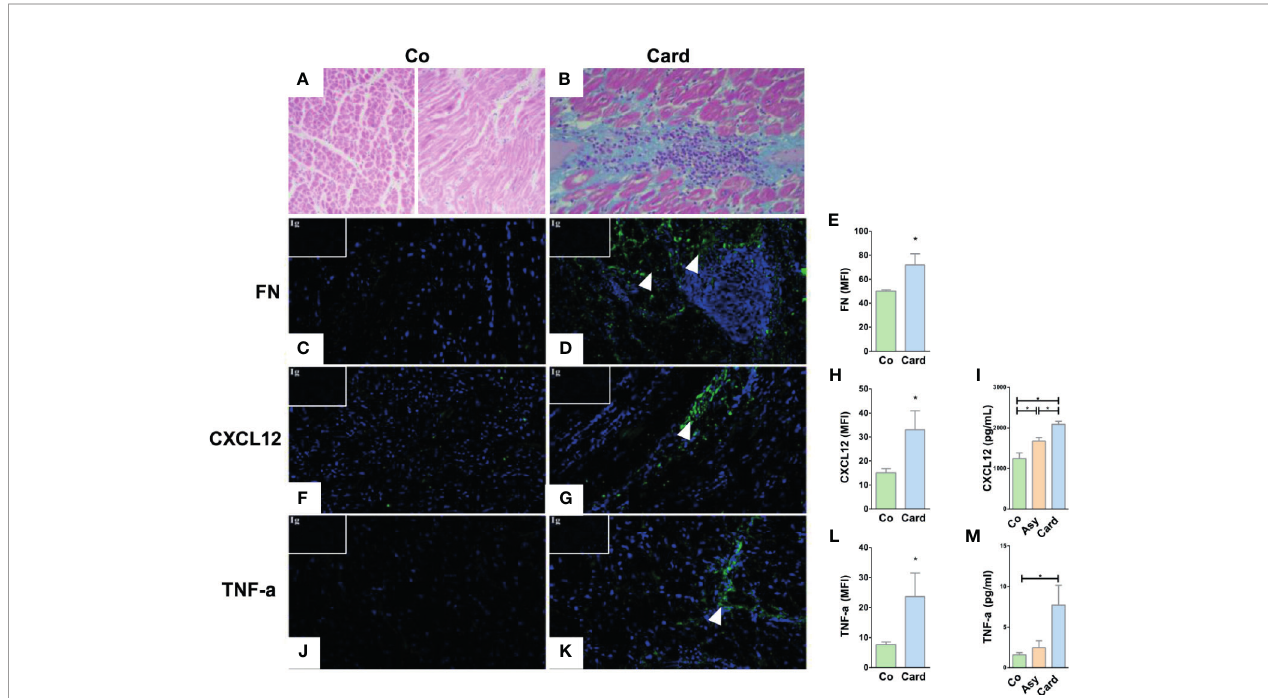
FIGURE 1 | Histological and immuno fl uorescence analyses of the cardiac tissue of Control subjects and T. cruzi – infected patients with chronic myocarditis. Hematoxylin and eosin staining of healthy myocardium from Control individuals (A) and from Cardiac patients (B) showing the typical diffuse in fl ammatory in fi ltrate of T. cruzi chronic infection associated with the in fl ammatory cell in fl ux. Immuno fl uorescence images reveals an increased fi bronectin (FN) deposition ( fi bronectin in green, cell nuclei in blue) in the heart sections from Cardiac patients compared to Controls (C, D) . The mean fl uorescence intensity (MFI) of fi bronectin was also increased in the Cardiac group (E) . CXCL12 immunolabeling (CXCL12 in green, cell nuclei in blue) showed an augmented expression (F, G) and MFI (H) in Cardiac patients compared to Controls. Systemic amounts of CXCL12 are also enhanced in T. cruzi – infected individuals, despite being Asymptomatic or Cardiac (I) . Immuno fl uorescence images of heart sections from Cardiac patients showing an increased TNF- a expression (TNF- a in green, cell nuclei in blue) (J, K) and MFI (L) compared to Controls. Systemic amounts of TNF- a are also enhanced in Cardiac individuals (M) . Isotype controls are shown in the upper left corner of each image. In all cases, MFI was evaluated by measuring fi ve images/heart per study group (Control, n = 3 and Cardiac, n = 3). *p < 0,05 versus Controls. Mann-Whitney U test was used for statistical analyses. Co, Control; Asy, Asymptomatic; Card,